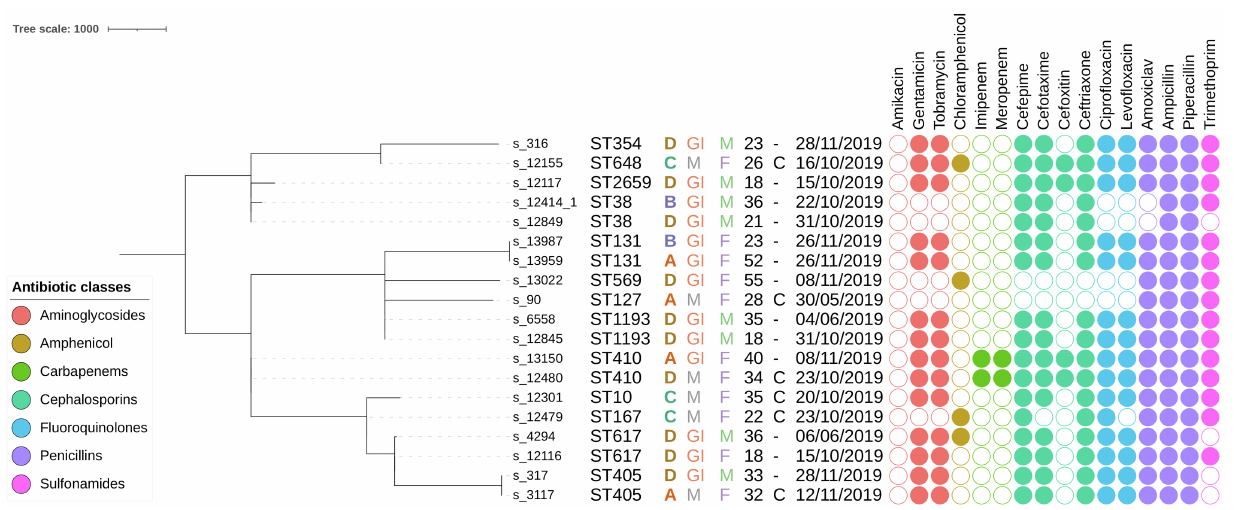
FIGURE 2 | Minimum spanning tree containing all E. coli samples sequenced in this study based on cgMLST results. The scale bar expresses the number of allele differences. Annotations are (from left to right) sample name, sequence type (based on classical MLST), hospital letter code, hospital ward, patient gender, patient age, surgical intervention, isolation date, and phenotypically determined AMR susceptibility (a filled circle indicates phenotypic resistance to the corresponding antibiotic). Circles are colored according to the class of the antibiotic as indicated in the legend in the bottom left corner. Abbreviations: maternal (M), gastrointestinal (GI), male (M), female (F), and caesarian